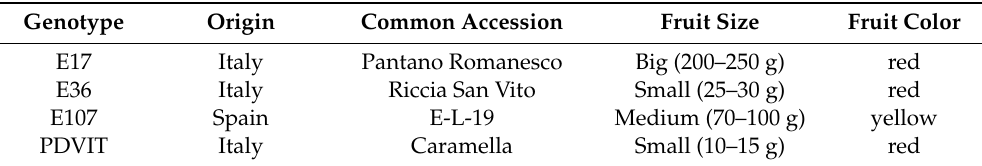
Table 1. Details of the tomato genotypes used in this